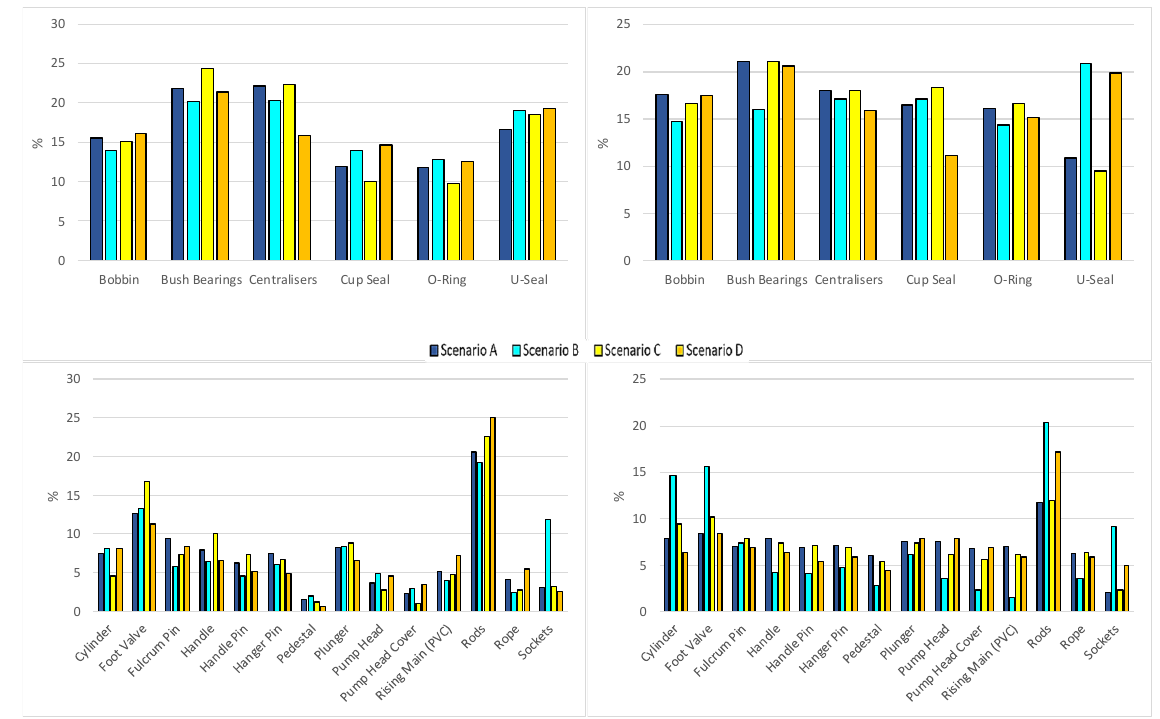
Figure 5. Distribution of fast-wearing (top) and of longer-life (bottom) components (noted on the x axis) by scenario for assets with no rehabilitation (left) and rehabilitation conducted (right) for each scenario (A–D).